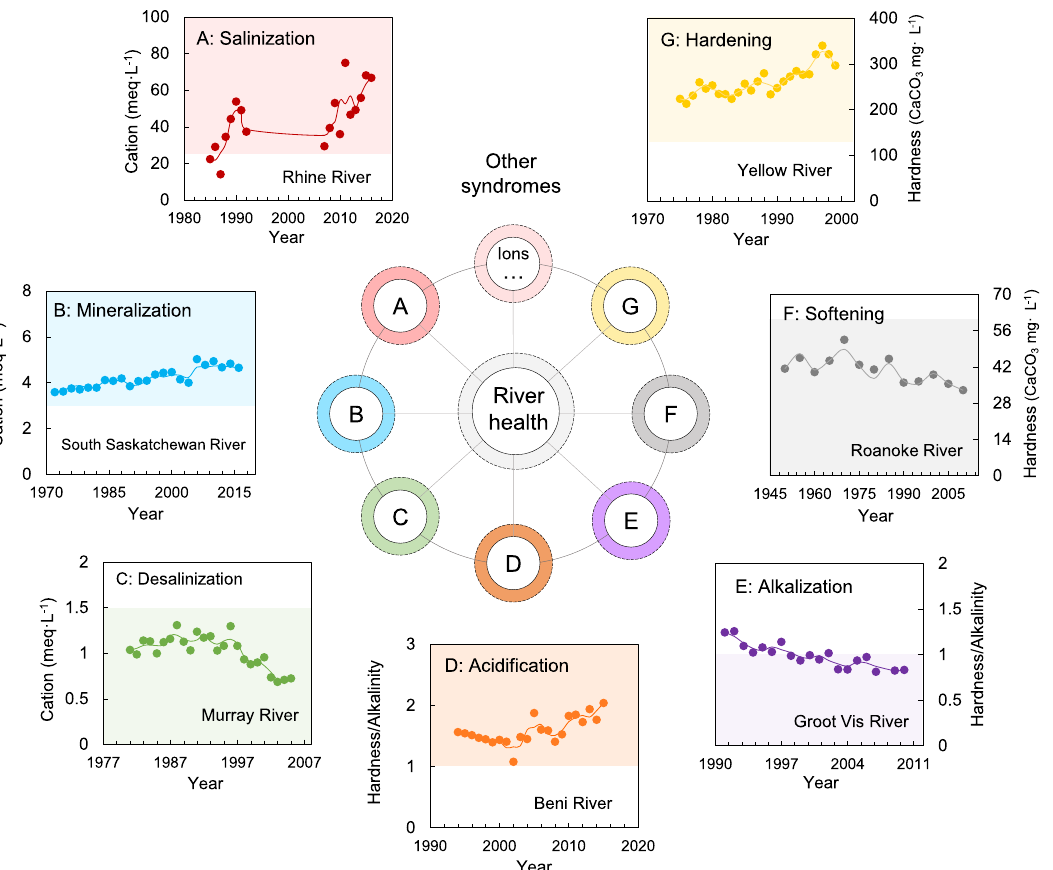
Fig. 3 River syndromes induced by extreme changes in solutes. A – G represent seven river syndromes associated with ion concentration. The colored area indicates that the river is experiencing a speci fi c syndrome as the solute metric exceeds a certain threshold. The central open circle refers to the ion concentration range when the river ecosystem is in a healthy state. Colored annuli refer to ion concentrations that exceed prescribed thresholds, causing river syndromes. Colored dots in (A – G) denote measured data, and colored lines indicate the three-year moving